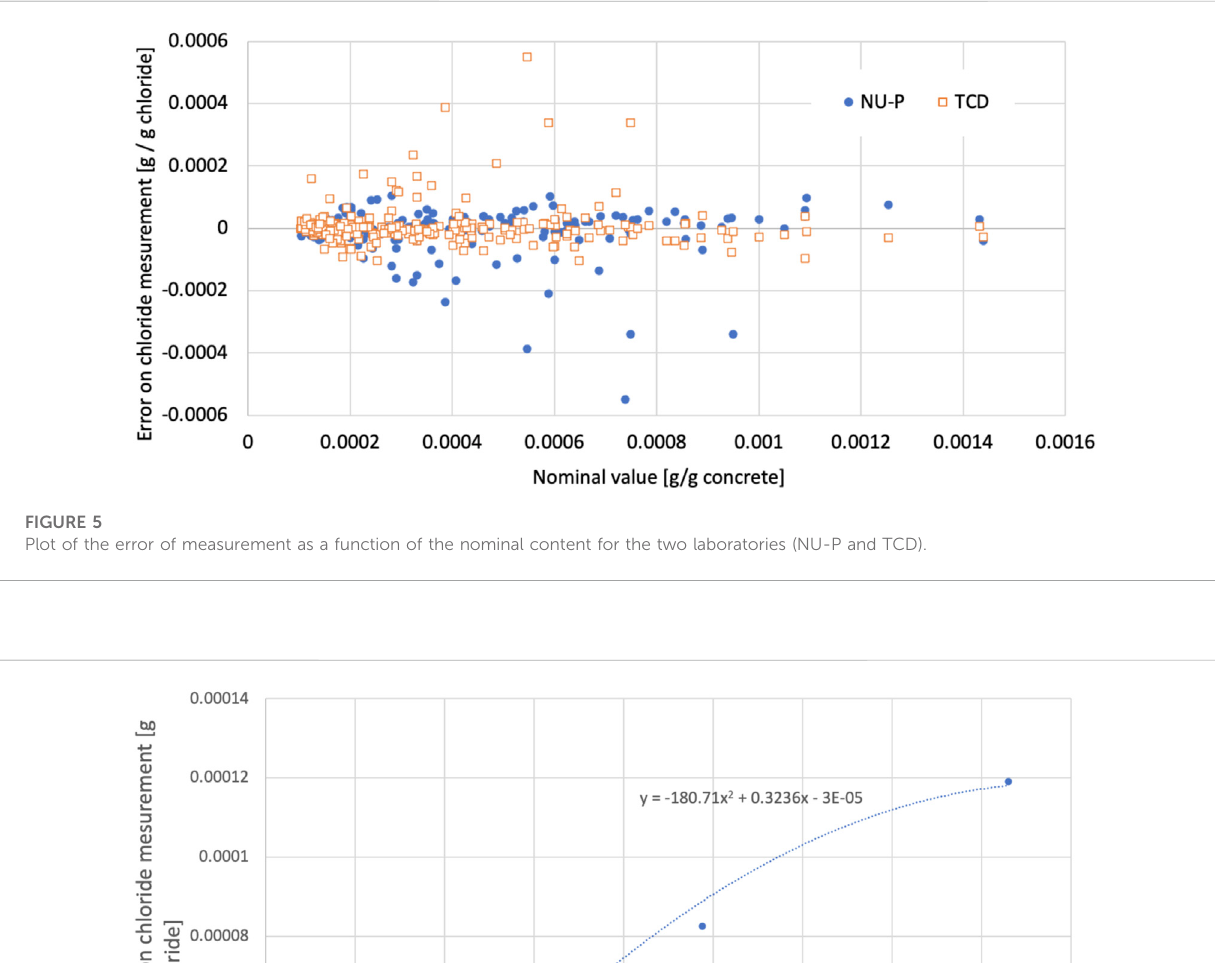
Frontiers in Built